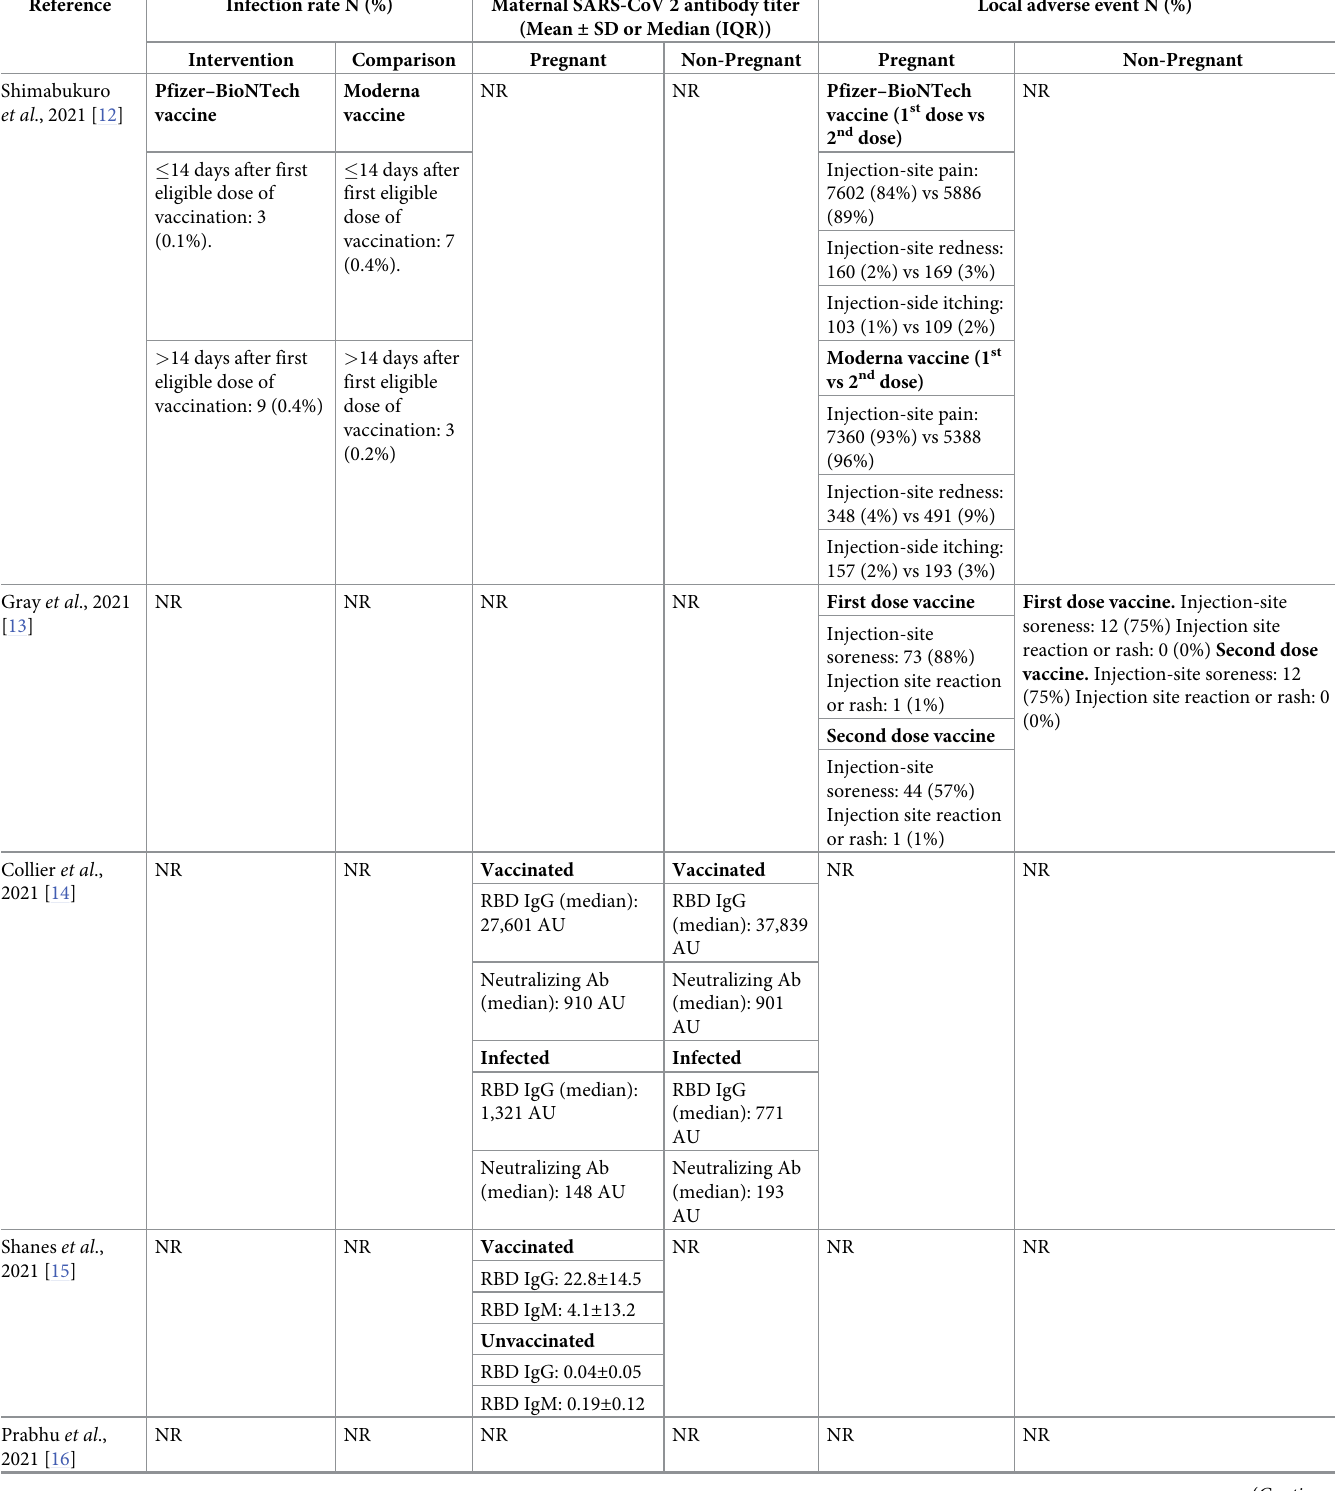
Table 2. Outcomes of the individual studies.